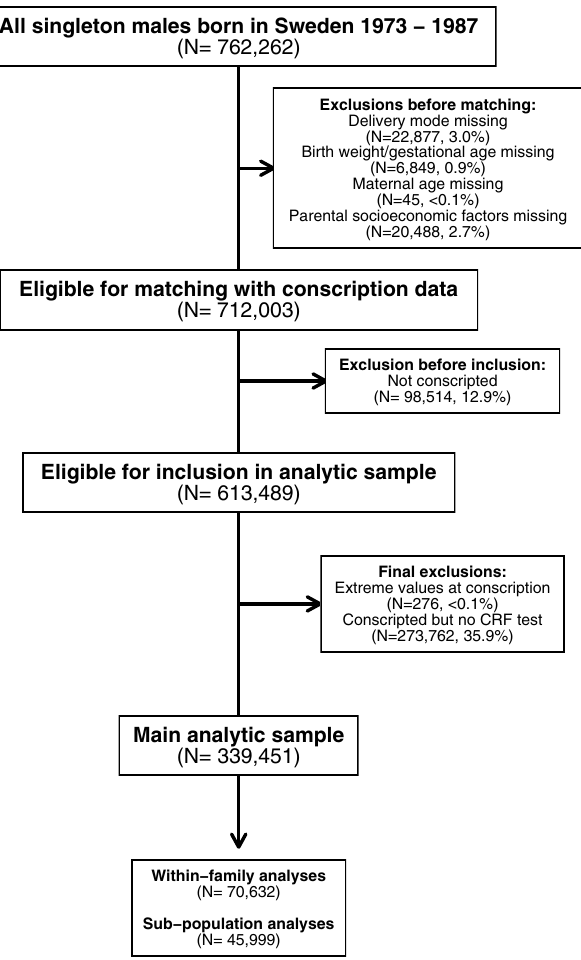
Figure 1. Construction of main analytic sample, family clusters and analytic